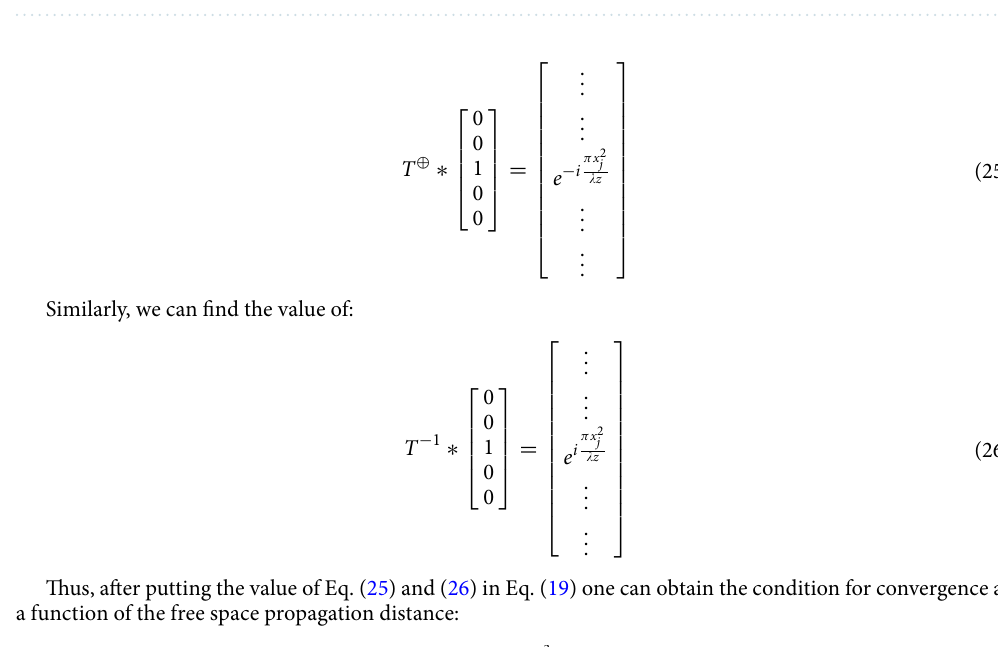
Figure 12. Flowchart describing the steps involved in Particle Swarm Optimization